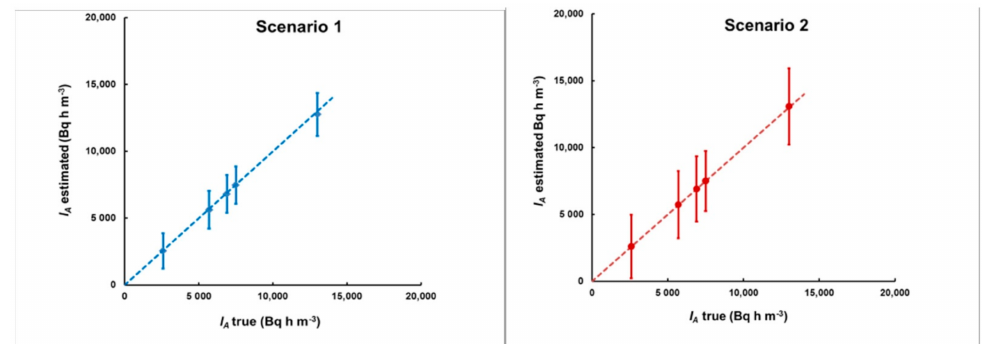
Figure 13. The estimated integrated activity concentrations for the plumes of Figure 11 for the first ( left ) and the second ( right ) delay scenario. As with the delay estimates, here, the methodological bias (the deviation of the points from the dashed line that corresponds to “estimated = true I A ”) is also much smaller than the “counting statistics uncertainty” (error